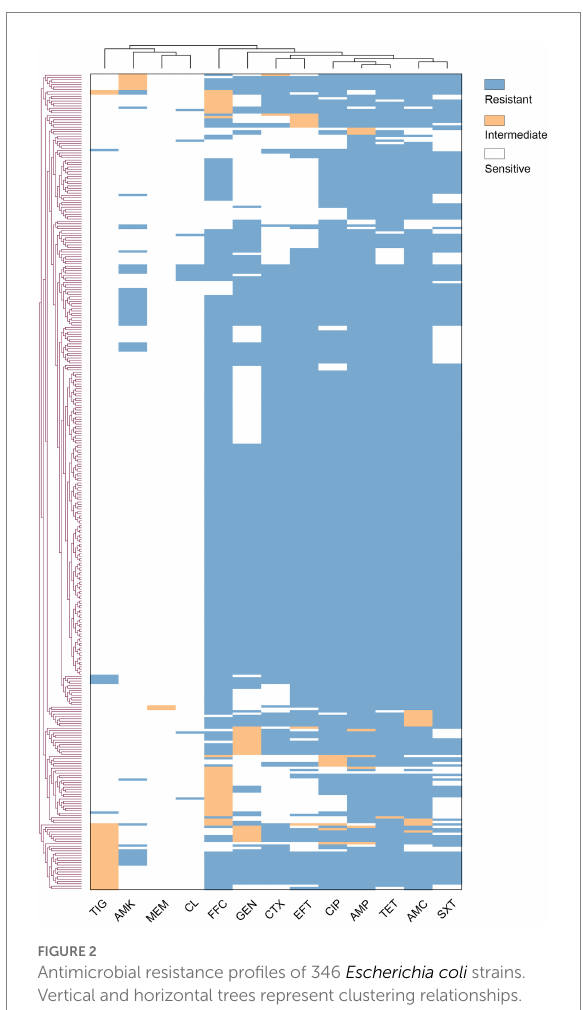
FIGURE 2 Antimicrobial resistance profiles of 346 Escherichia coli strains. Vertical and horizontal trees represent clustering relationships. The abscissa is the antibiotic, and the ordinate is the E. coli